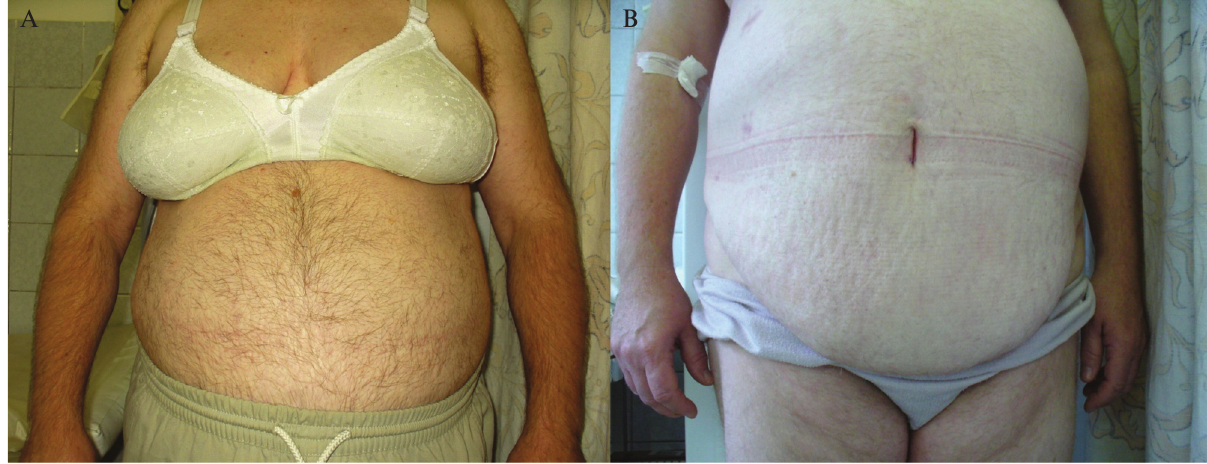
Fig. 1. Before the treatment. Typical picture of hirsutism (A). Half a year after the sugical procedure (B). Nearly perfect retreat of